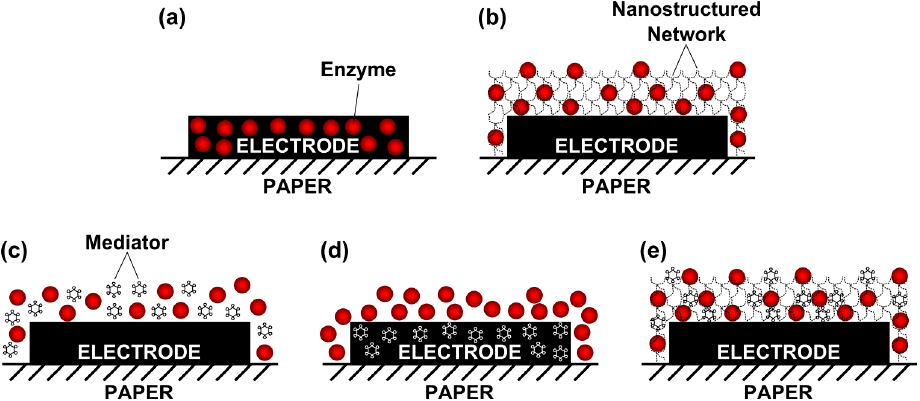
Figure 2. Surface modification strategies of paper-based enzymatic biosensors: ( a ) inkjet-printed graphene–enzyme composite; ( b ) biomolecule drop cast over nanostructured layer; ( c ) biomolecule and redox mediator mixture drop casting; ( d ) screen-printed carbon–redox mediator composite with biomolecule drop casting; ( e ) biomolecule and redox mediator mixture drop casting over nanostructured layer.